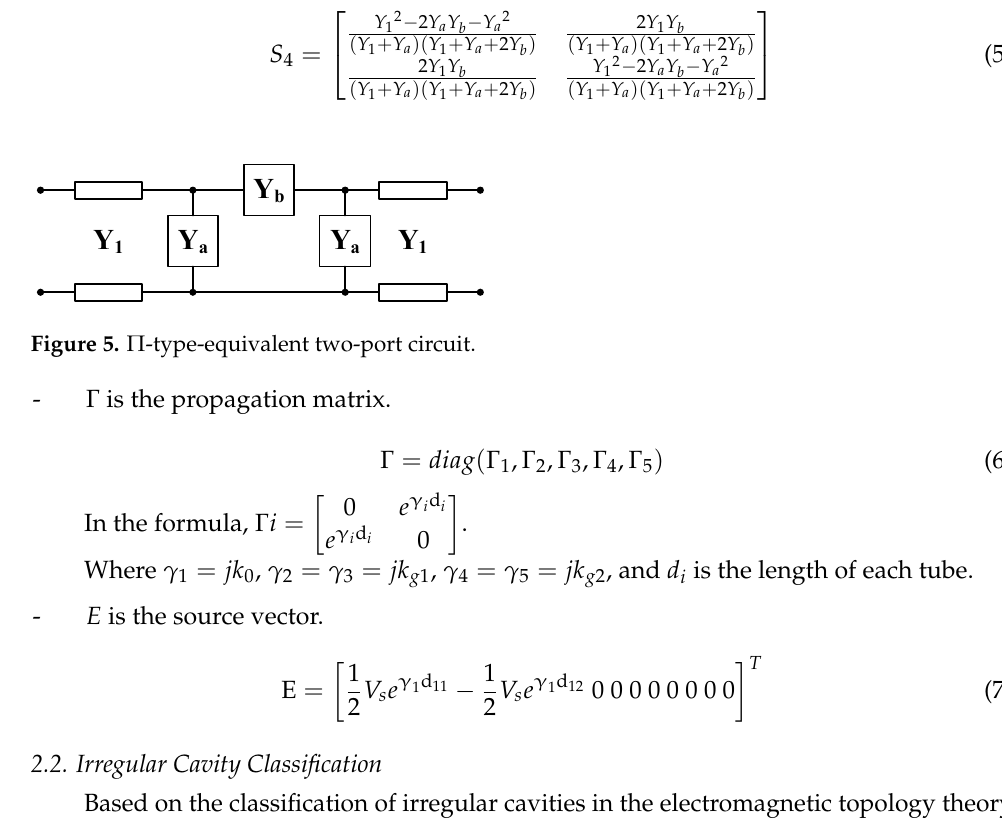
cles with finite thickness, f) Inductive obstacles with finite thickness.